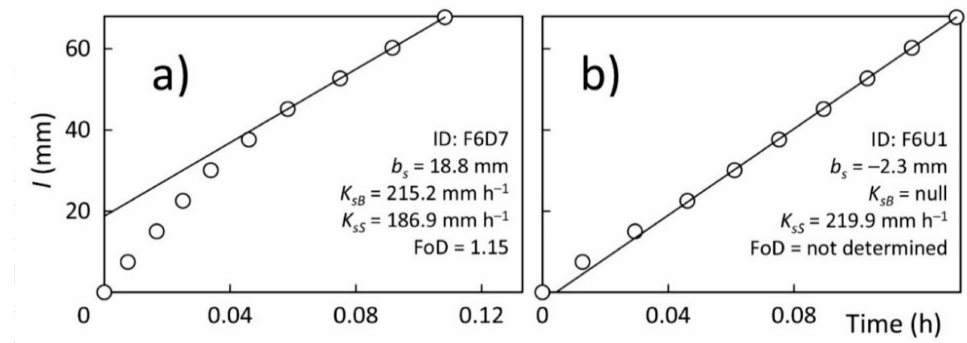
Figure 2. Illustrative examples of the influence of the shape of the cumulative infiltrations on the discrepancies occurring between the Beerkan method (BEST-steady) and the steady-state phase of a Beerkan infiltration (SSBI) method. ( a ) Concave-shaped cumulative infiltration curve in which the intercept, b s (mm), of the straight line interpolating the last I vs. t data points is positive and the FoD between the saturated soil hydraulic conductivity values estimated with BEST-steady ( K sB ) and the SSBI method ( K sS ) is small. ( b ) Convex-shaped cumulative infiltration curve with a negative intercept yielding null K sB .